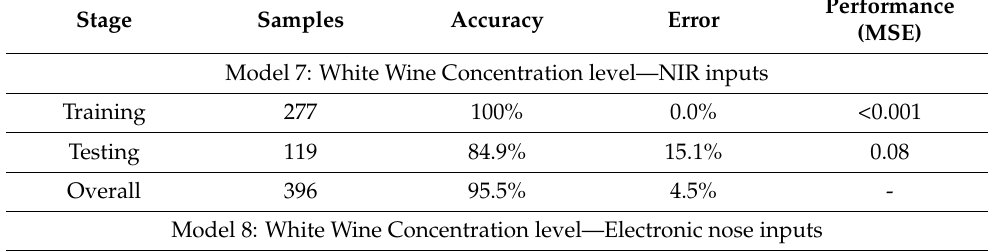
Table 4. Accuracy and performance based on means squared error (MSE) of machine learning models 1–6 developed for white